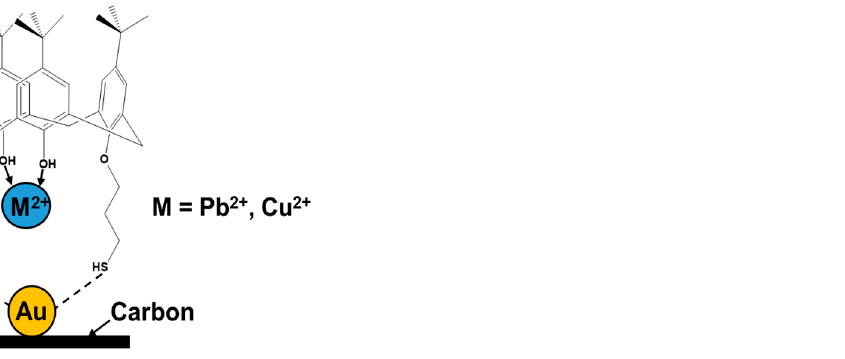
with Pb 2+ and Cu 2+ . Figure 6. Schematic representation of the binding and complexation mode of TC4/AuNPs/SPCE